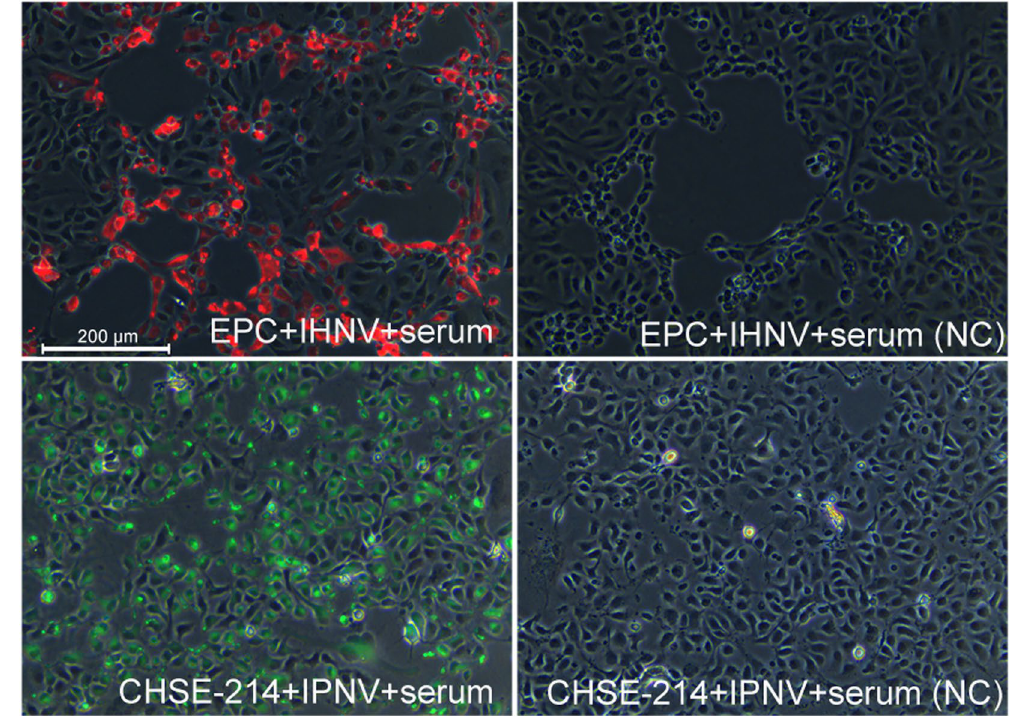
Figure 6. Specificity of NAb serum for IHNV and IPNV. Virus-infected cells were incubated with NAb- containing serum (from vaccinated trout), a rabbit polyclonal antibody directed against rainbow trout IgM Fc, and a fluorescently labelled secondary antibody. Sera from trout vaccinated with pcDNA3.1 were used as the negative controls. NC: negative